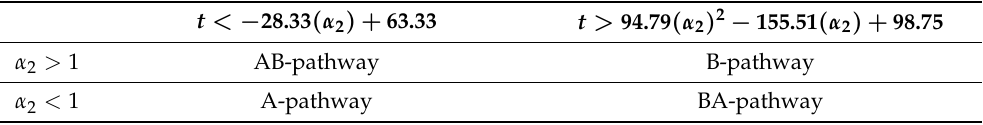
Table 2. The table shows the dominant pathways for given choice of time and mutability. Estimations for the conditionals are based on the general shape of the phase diagram. Most notably, α 2 has a noticeable switch at about α 2 = 1, while the time at which a pathway switch occurs is based on the magnitude of α 2 . The equations shown as column headers are best-fit curves for the borders of red/purple and